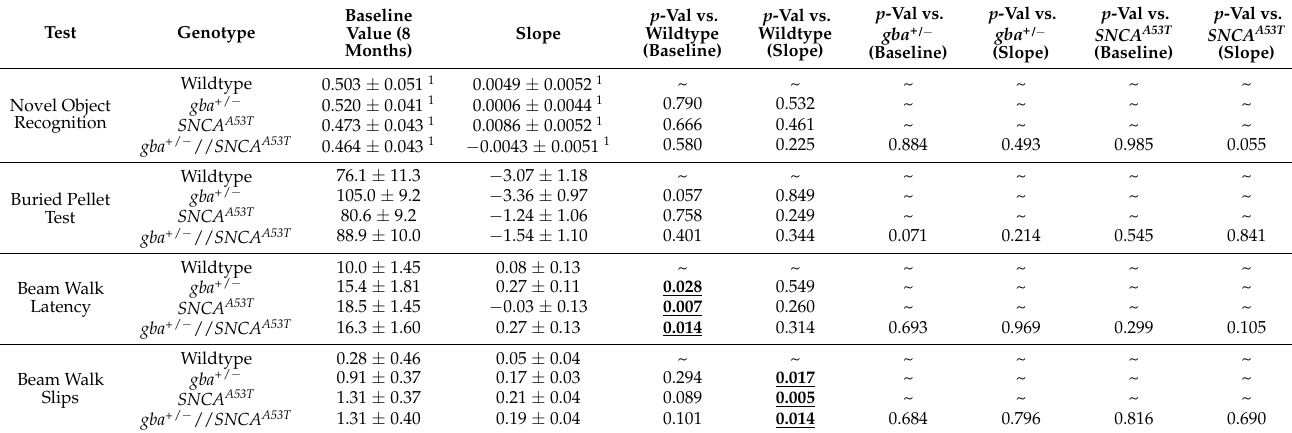
Table 1. Results of the longitudinal mixed-effects models for the three behavioral parameters assessed. p -values compar- ing both the intercept (9-month baseline score) and slope values between genotypes are provided. Significant p -values ( p < 0.05) are underlined and in bold. For all tests except the novel object recognition test, a more positive slope value indicates worsening performance over time.